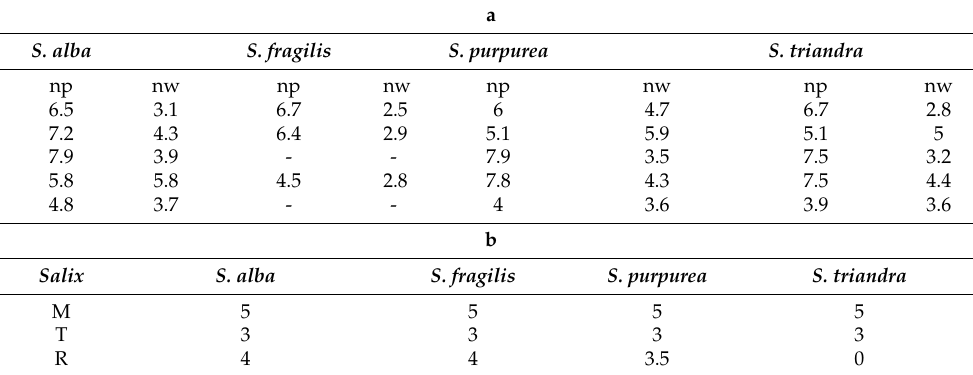
Table 1. Values for niche position and niche